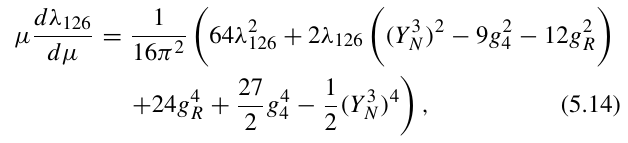
and m 1 , 2 correspond to their maximum values for tively. The Y 1 , 2 N N fixed T R = 10 − 2 M PS , chosen to prevent the restoration of the PS